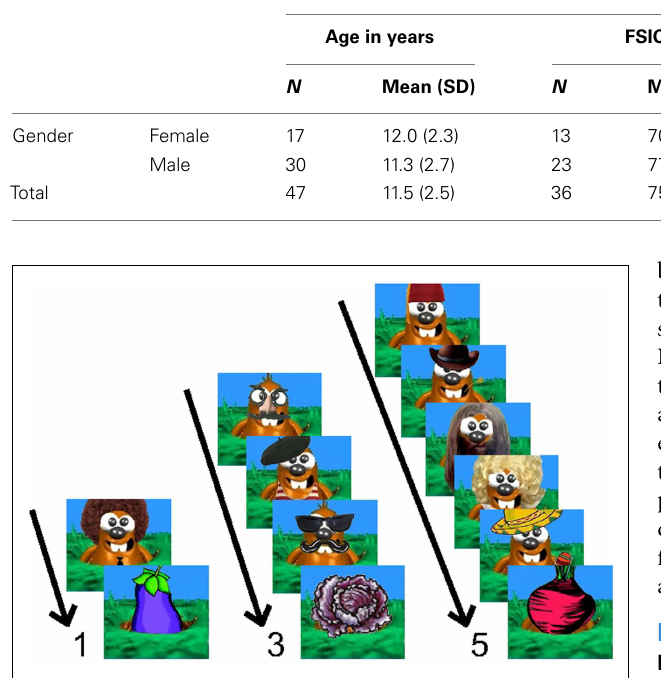
FIGURE 1 | Example trials from the “whack-a-mole” Go/No-Go task . Children were instructed to press a button as quickly as possible when a cartoon mole appeared (Go trial), but to avoid pressing the button when a vegetable appeared (No-Go trial). Go trials appeared 75% of the time, while No-Go trials appeared the other 25% and were preceded by one, three, or five Go